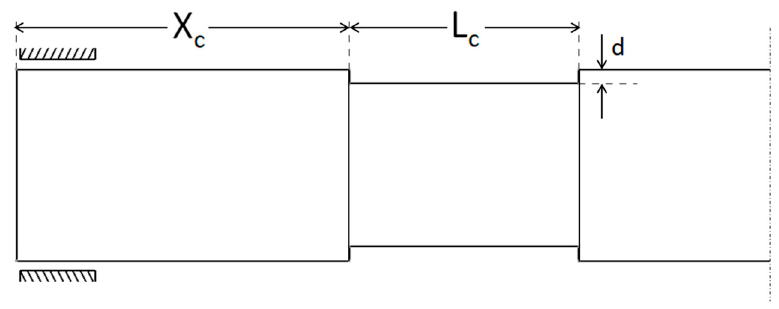
Figure 4. Various parameters of corrosion defect in the functionally graded rotor-bearing system.